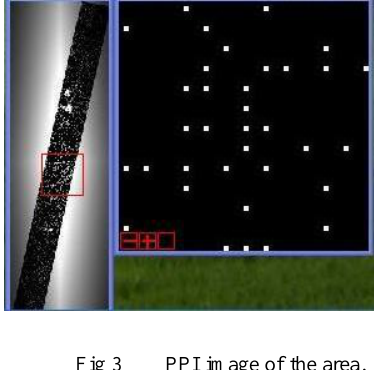
Fig 3 PPI image of the